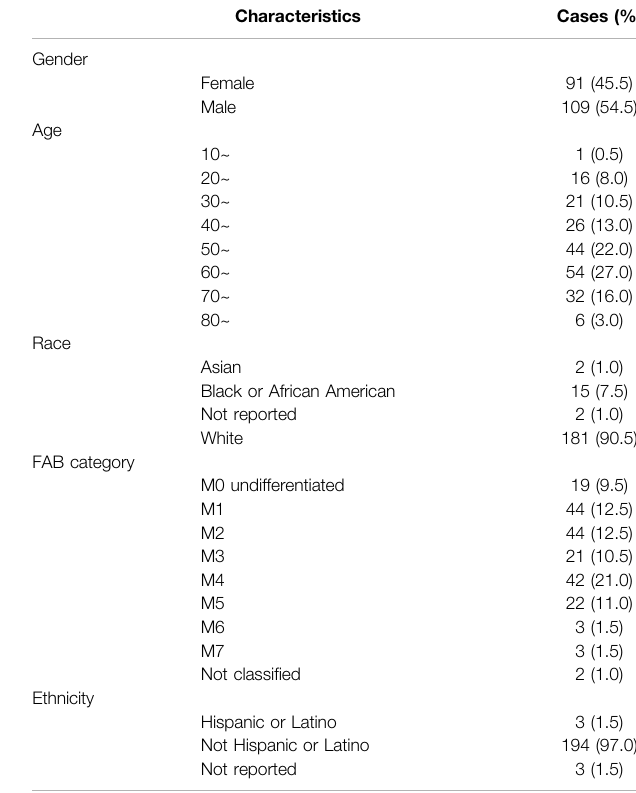
TABLE 2 | Baseline characteristics for 200 patients with AML in the TCGA database ( n = 200).